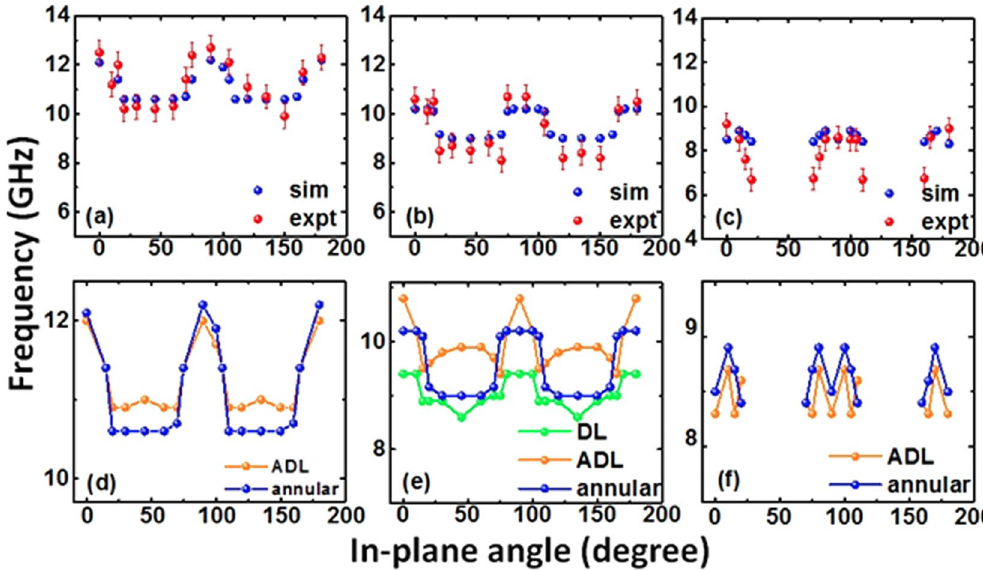
Figure 3. Variation of SW frequency of ( a ) mode 1 ( b ) mode 2 and ( c ) mode 3 of the annular antidot lattice with the in-plane angle of the bias field varying from 0° to 180° at a fixed H = 1080 Oe obtained from both experiment and simulations. The origin of ( d ) mode 1 ( e ) mode 2 and ( f ) mode 3 of annular antidot lattice studied by comparing with individual DL and